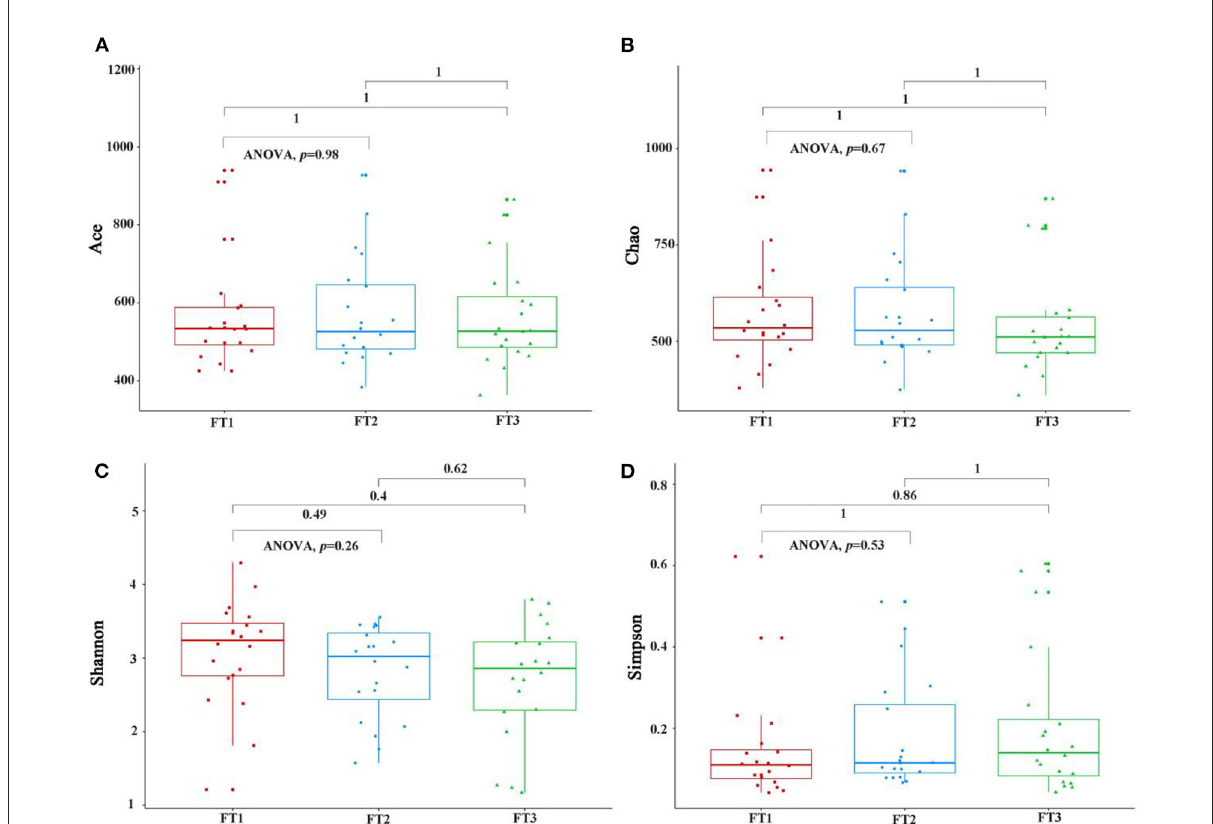
FIGURE4 The gut microbial α -diversity, as assessed with the ACE (A) , Chao (B) , Shannon (C) , and Simpson (D) indexes among three groups. FT1 (tertile 1) means the gut microbiomes of the most anti-inflammatory diet group, FT2 (tertile 2) means the gut microbiomes of the no anti-inflammatory/pro-inflammatory diet group, and FT3 (tertile 3) means the gut microbiomes of the most pro-inflammatory diet